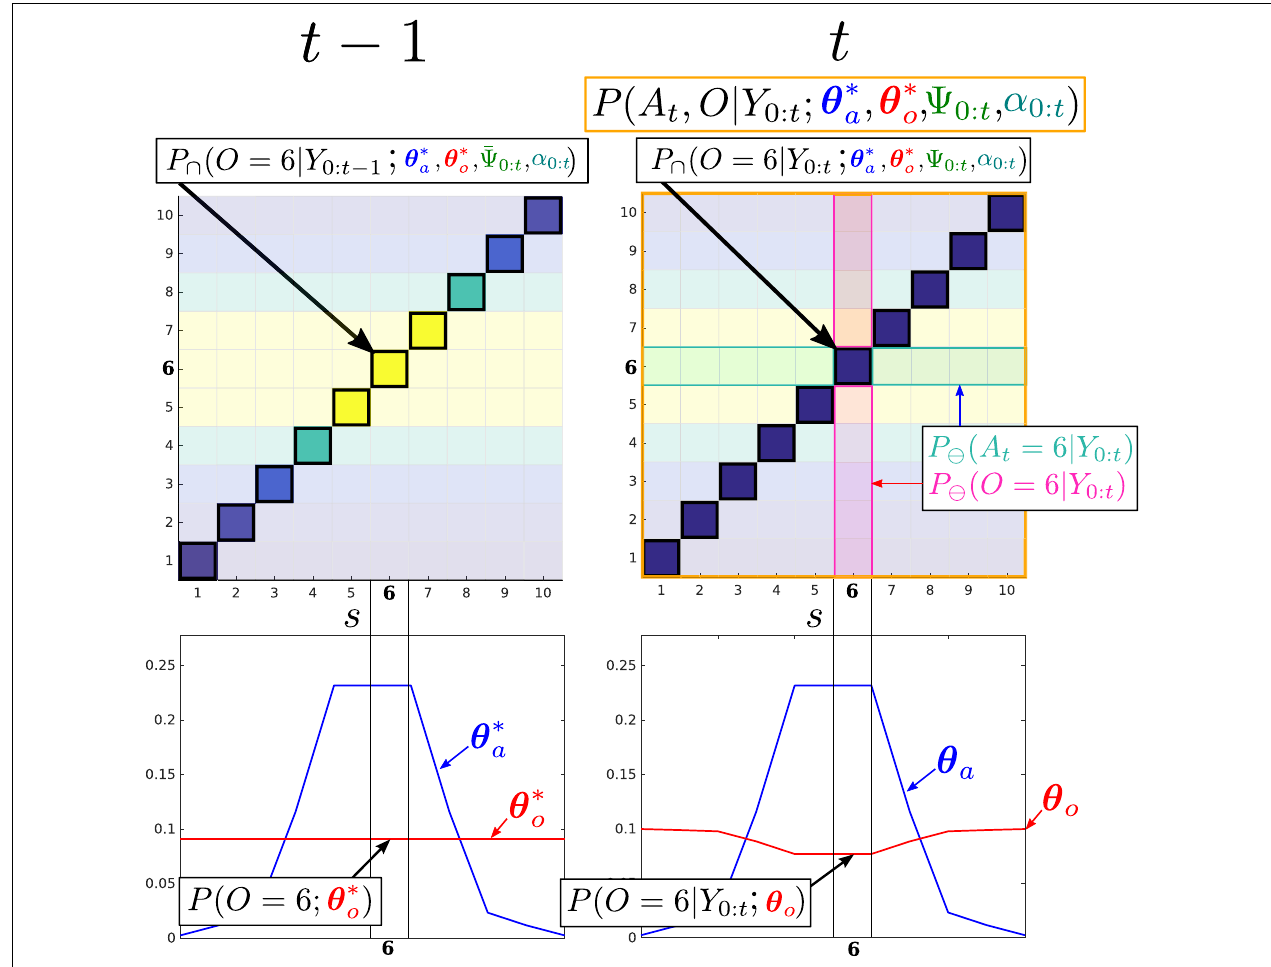
FIGURE 7 | Filtered marginals. Illustration of the agent and object marginal update (equation (20)). The joint distribution parameters that are independent A ⊖ O are pale, and the dependent areas A ∩ O , where P ( Y t < 1| A t , O ), are bright. MLMF only evaluates the joint distribution in dependent states. For each state s of the marginals 1, ... , 10, the difference of the marginals inside the dependent area, before and after the measurement likelihood is applied, is evaluated and removed from the marginals P ( A t | Y 0: t (cid:0) 1 , u 1: t ; (cid:18) a ), P ( O | Y 0: t (cid:0) 1 ; (cid:18) o ) leading to P ( A t | Y 0: t , u 1: t ; (cid:18) a ), P ( O | Y 0: t ; (cid:18) o ) (we did not show u 1: t in the figure for ease of notation). Bottom left : joint marginals P ( A t | u 1: t ; (cid:18) (cid:3) a ) and P ( O ; (cid:18) (cid:3) o ) remain unchanged by measurements.